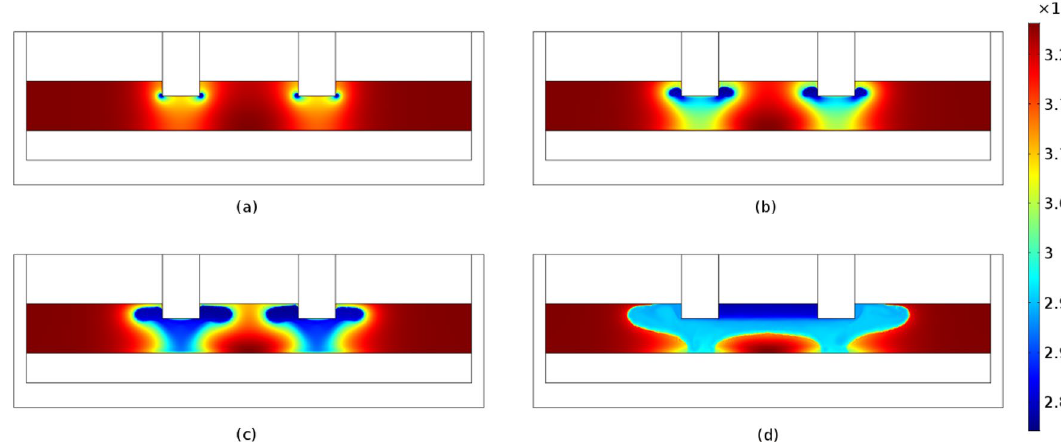
Figure 9. Distribution of slag density (kg/m 3 ) with respect to times of ( a ) 2500 s, ( b ) 5000 s, ( c ) 7500 s and ( d ) 10,000 s. As expected, these snapshots are inversely proportional to the temperature distributions (Fig. 7).